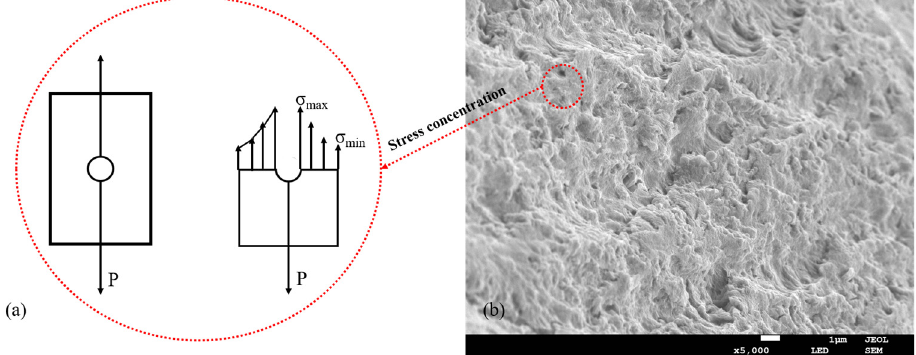
Figure 7. ( a ) The schematic presentation of the stress concentration of SA/AKP/CNCs composite fiber, ( b ) the cross-section morphology of SA/AKP/CNCs composite fiber.